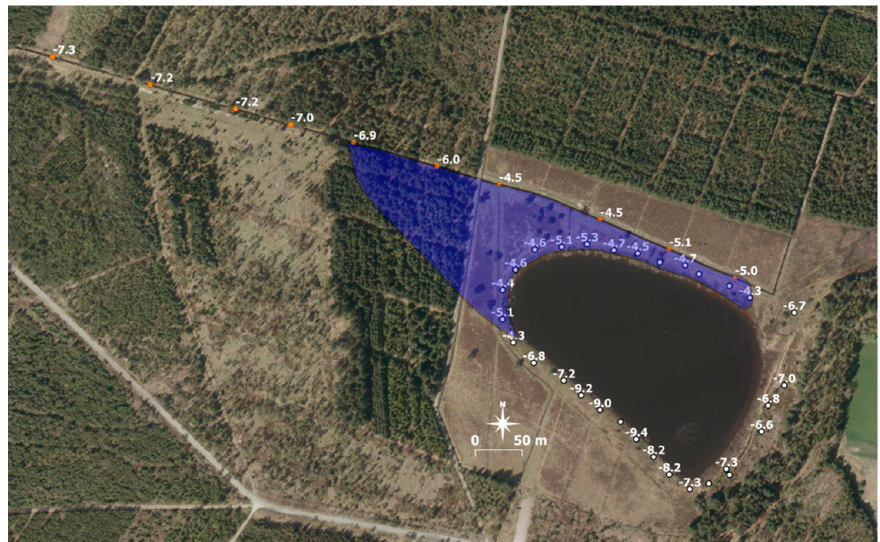
Figure 7. Plume of lake-enriched δ 18 O recharging groundwater on the northwestern side and flowing to Bøgsted Ditch and mixing with groundwater from the north. Points show observations around the lake and in the ditch. TA18 inside this plume confirms this interpretation (Figure 5B). Lake samples are from February 2016 and surface water ditch samples from 22 August 2017.